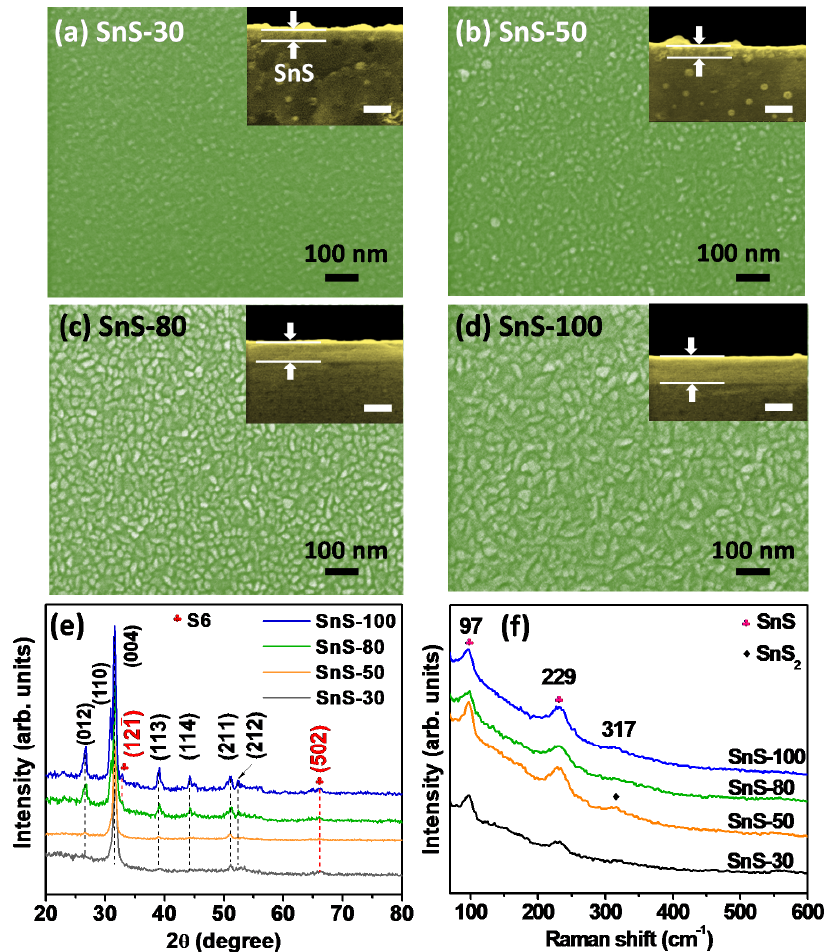
Figure 2. ( a – d ) SEM surface images of di ff erent as-deposited SnS thin films. The insets show cross-sectional SEM images with the corresponding thicknesses (the scale bar represents 100 nm). ( e ) X-ray di ff raction spectra and ( f ) Raman spectra of as-deposited SnS thin films.